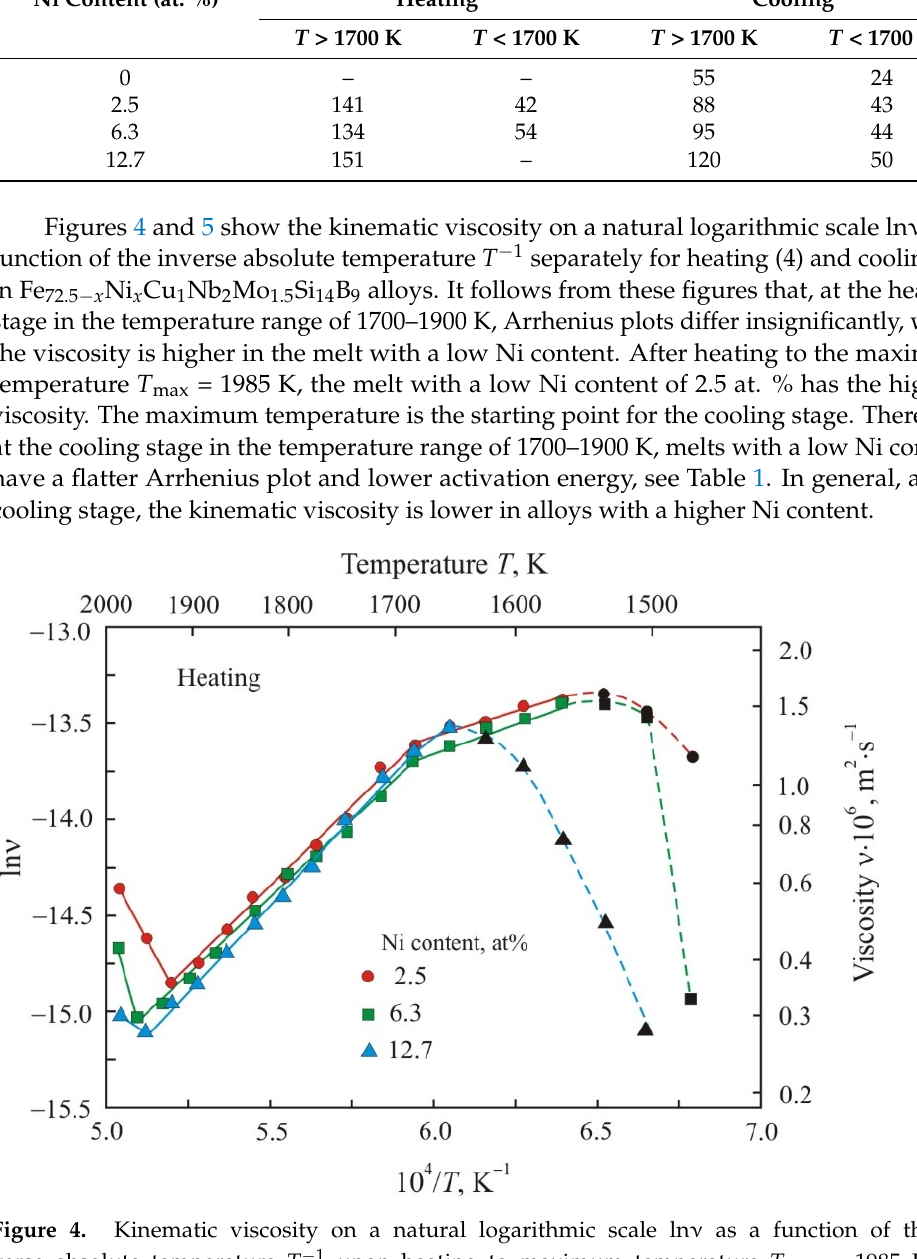
verse absolute temperature T − 1 upon heating to maximum temperature T max = 1985 K the temperature T − 1 upon heating to maximum temperature T max = 1985 K the